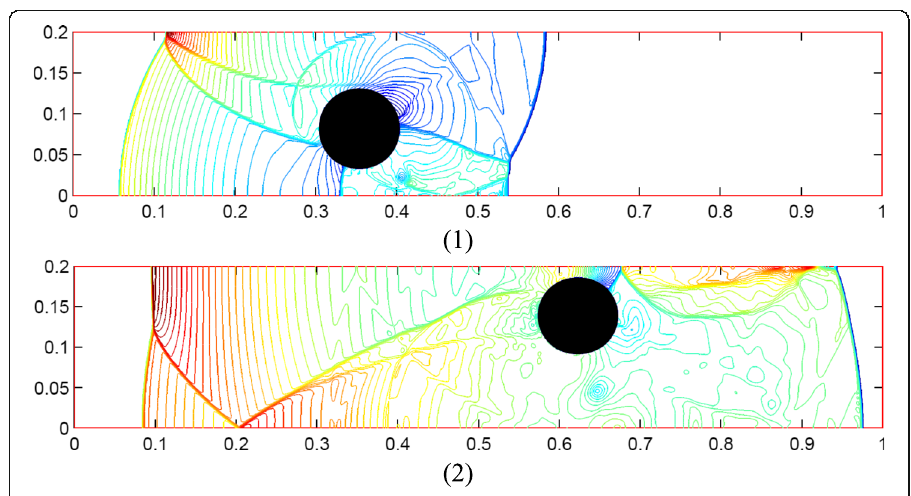
Fig. 11 Pressure contours computed by Shyue [31] at different time: (1) t = 0.1641 s , and (2) t = 0.30085